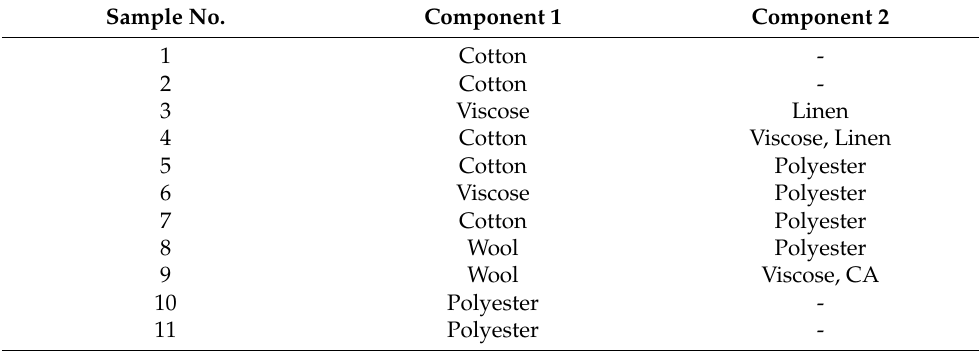
Table 2. Fabric material